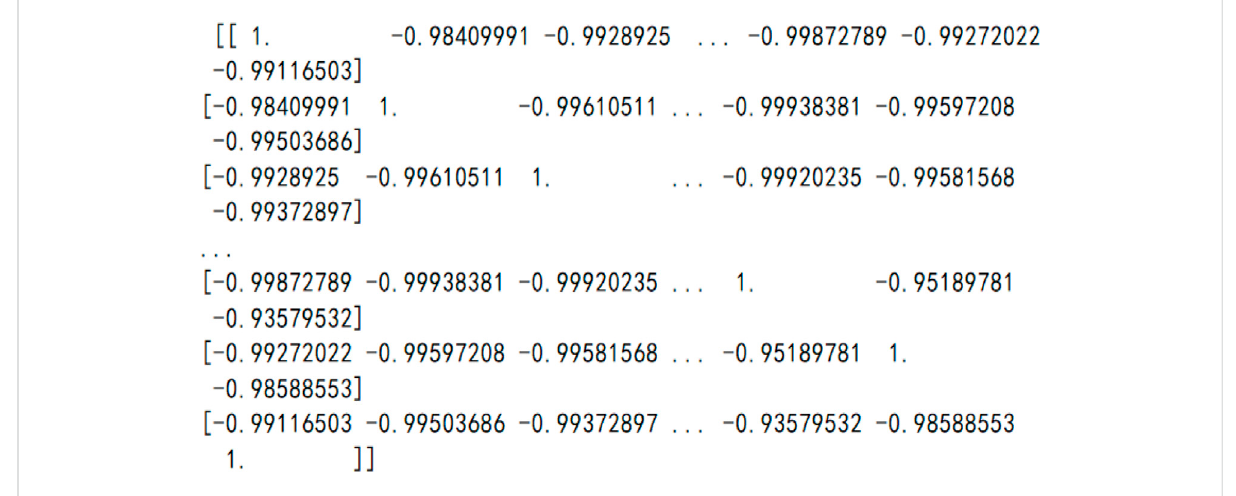
FIGURE 4 Screenshot of a part of the adjacency matrix.